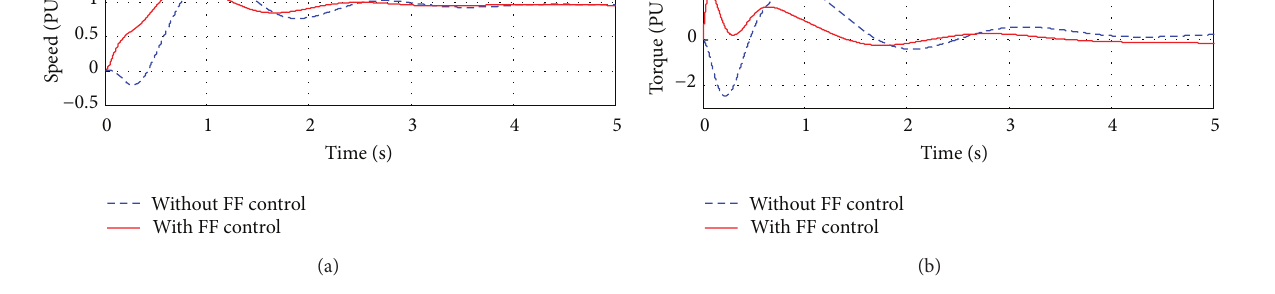
Figure 12: Speed, torque response of IOL control method.